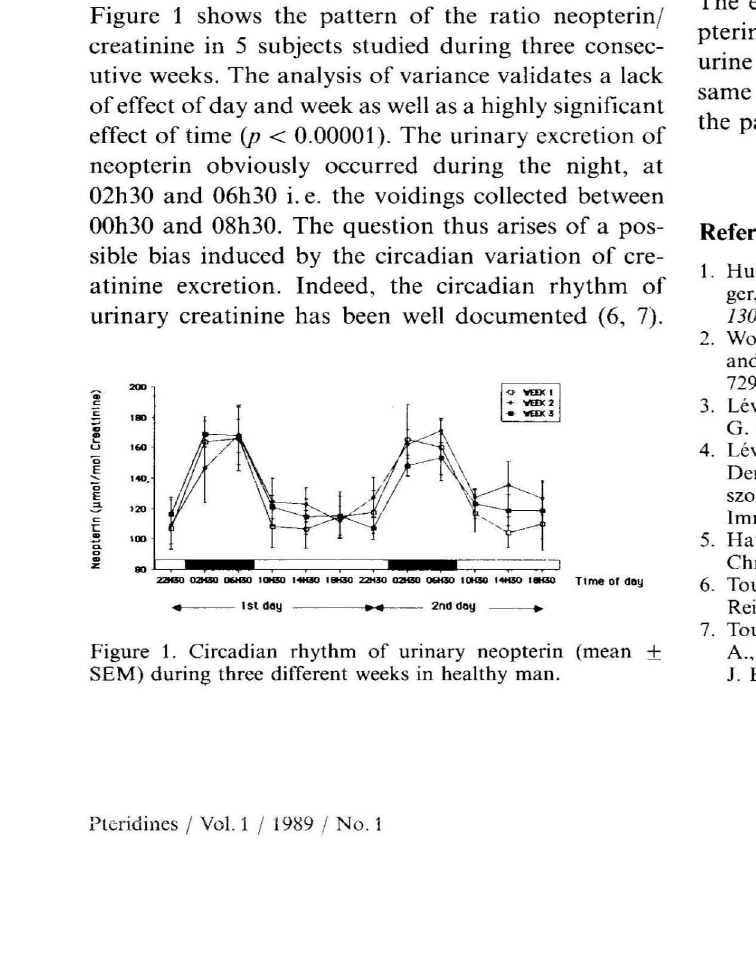
Pleridines j Vol. 1 j 1989 !